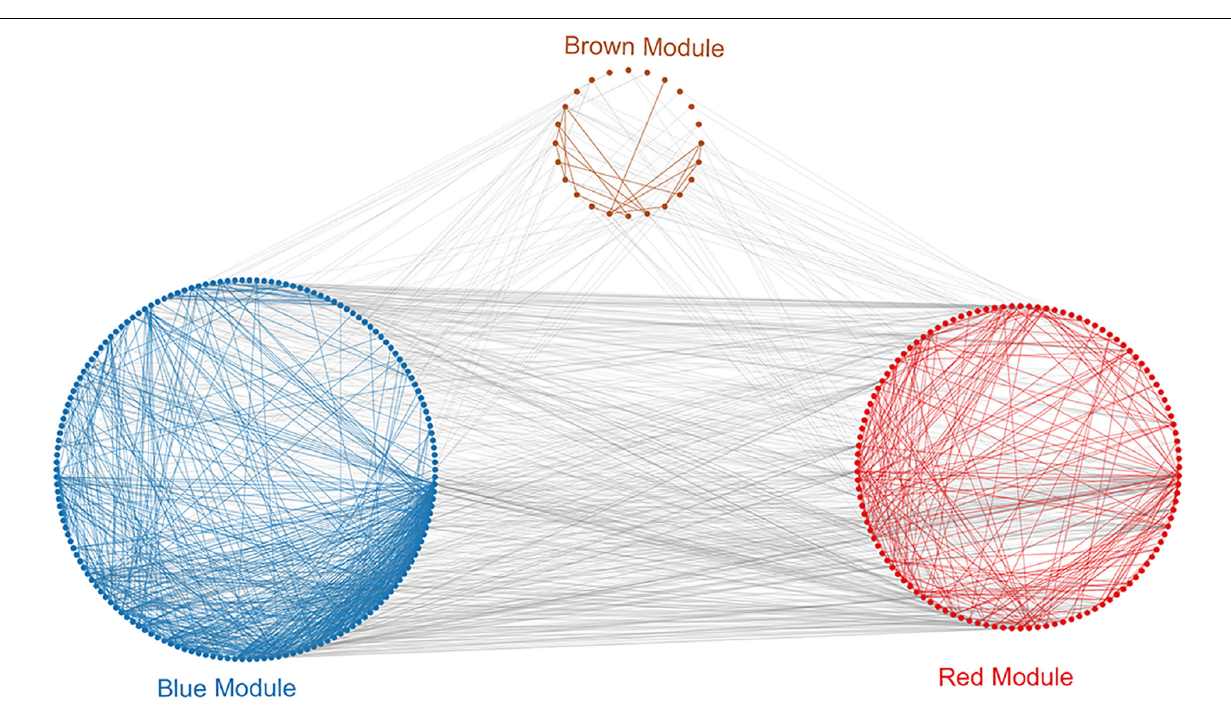
FIGURE 4 | Protein–protein interaction (PPI) analysis of clinically relevant modules. First use the genes in the module to perform protein interaction analysis in the STRING database. Further build an interaction network between the overall related genes based on different module colors. Red spots represent the genes in the red module, blue spots denote those in the blue module, and brown spots denote those in the brown